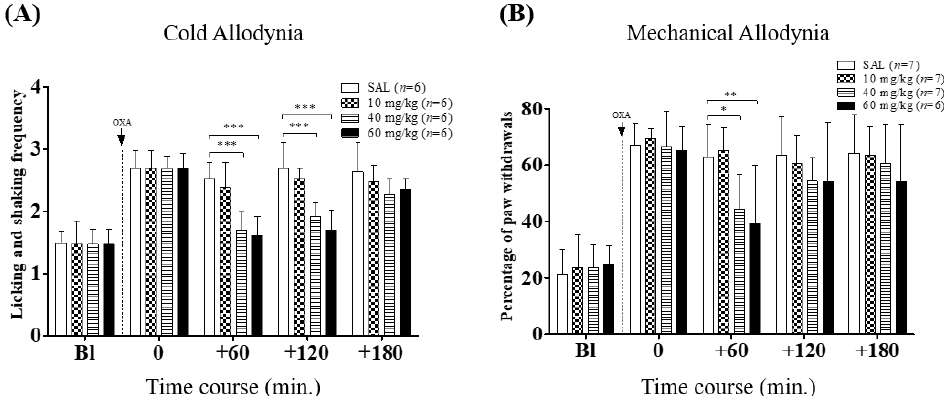
Figure 1. Elapsed time of the anti-allodynic effects of venlafaxine (VLX) on oxaliplatin-induced cold ( A ) and mechanical ( B ) allodynia in mice. Mice were divided arbitrarily into four groups. ‘SAL’ refers to saline, which was used as control, and “10”, “40” and “60 mg/kg” refers to the doses of VLX used. On the timeline, “Bl” refers to the baseline measured prior to the administration of oxaliplatin (OXA, 6 mg/kg, i.p., dotted line). “0” refers to the measurements performed just before the treatment of VLX or saline on day four. Data was expressed as mean ± standard deviations (S.D.). * p < 0.05, ** p < 0.01, *** p < 0.001, vs. saline with two-way ANOVA followed by Bonferroni’s post-test.